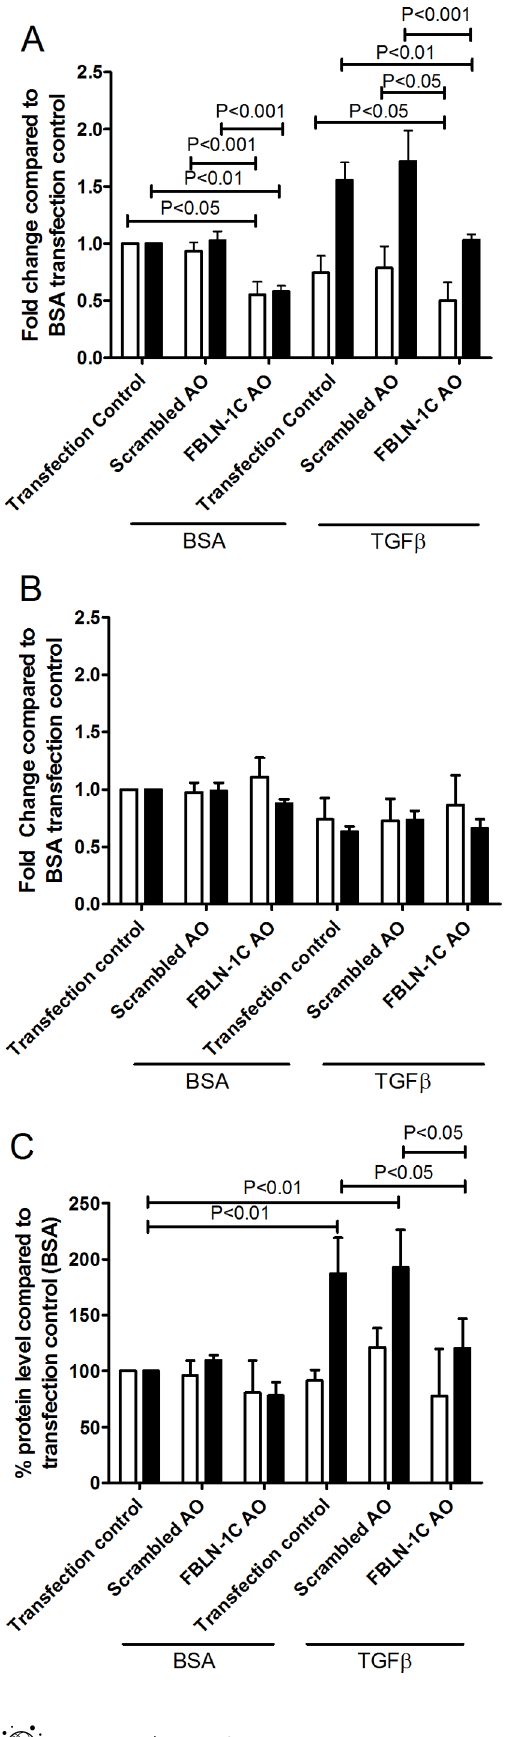
Figure 6. Efficiency and specificity of FBLN-1C AO. Inhibition of FBLN-1C (A) or FBLN-1D (B) mRNA following transfection with the FBLN- 1C AO or a scrambled AO in ASM cells collected from non-asthmatic (white bars, n=4) or asthmatic (black bars, n=4) volunteers basally or following treatment for 8 h with TGF b (data were normalized to 18s rRNA and are expressed relative to the transfection control at 8 h). FBLN-1 cellular and ECM deposited protein from ASM cells inhibited by a FBLN-1C specific AO (C). Data were normalized to a positive control (50% FBS) and are expressed relative to the transfection control. Data are expressed as mean 6